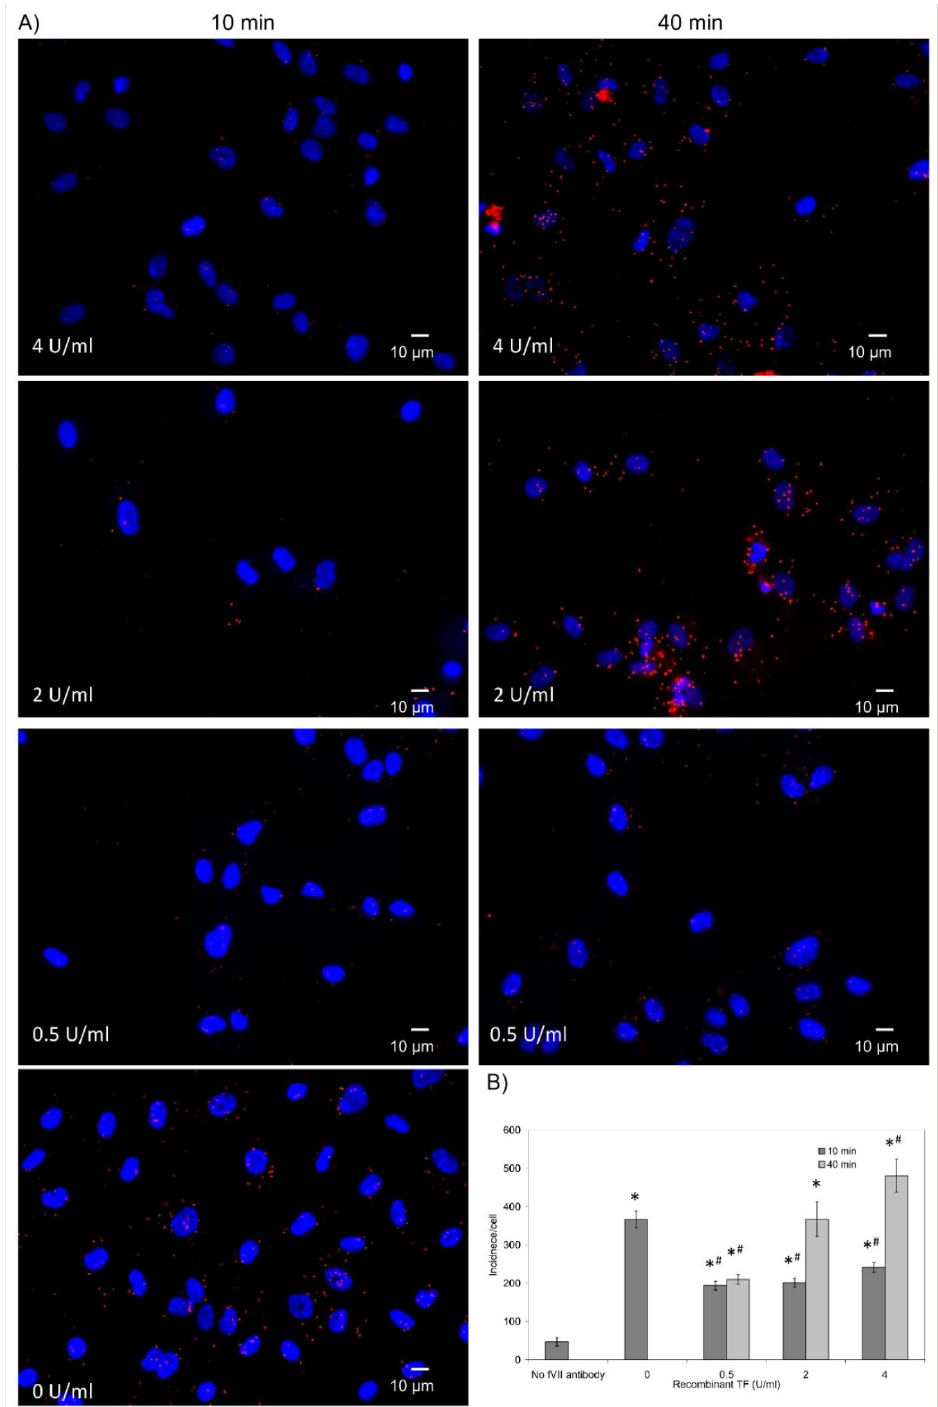
Figure 6. Analysis of the association of recombinant fVIIa with caveolin-1 on the surface of HDBEC on addition of recombinant TF: HDBEC (10 3 ). were seeded out into 35 mm-glass based µ -dishes overnight and treated with recombinant TF (1–4 U/mL) for 10 or 40 min. Cells were then fixed with 4% ( v / v ) paraformaldehyde for 15 min, washed three times with PBS for 5 min and blocked with Duolink blocking buffer for 1 h. The cells were then incubated overnight at 4 ◦ C with a mouse anti-fVII antibody (321621; 10 µ g/mL) and a polyclonal rabbit anti-caveolin-1 antibody (10 µ g/mL). ( A ) The dishes were washed three times with PBS and PLA performed according to the manufacturer’s instructions. The cells were stained with DAPI (2 µ g/mL) and images were acquired using a Zeiss Axio Vert.A1 inverted fluorescence microscope with a 40 magnification. ( B ) The number of red fluorescent events and nuclei were determined as incidence/cell in 10 fields of × view from each assay using the ImageJ program. ( n = 3; * = p < 0.05 vs. No fVII antibody; # = p < 0.05 vs. No TF